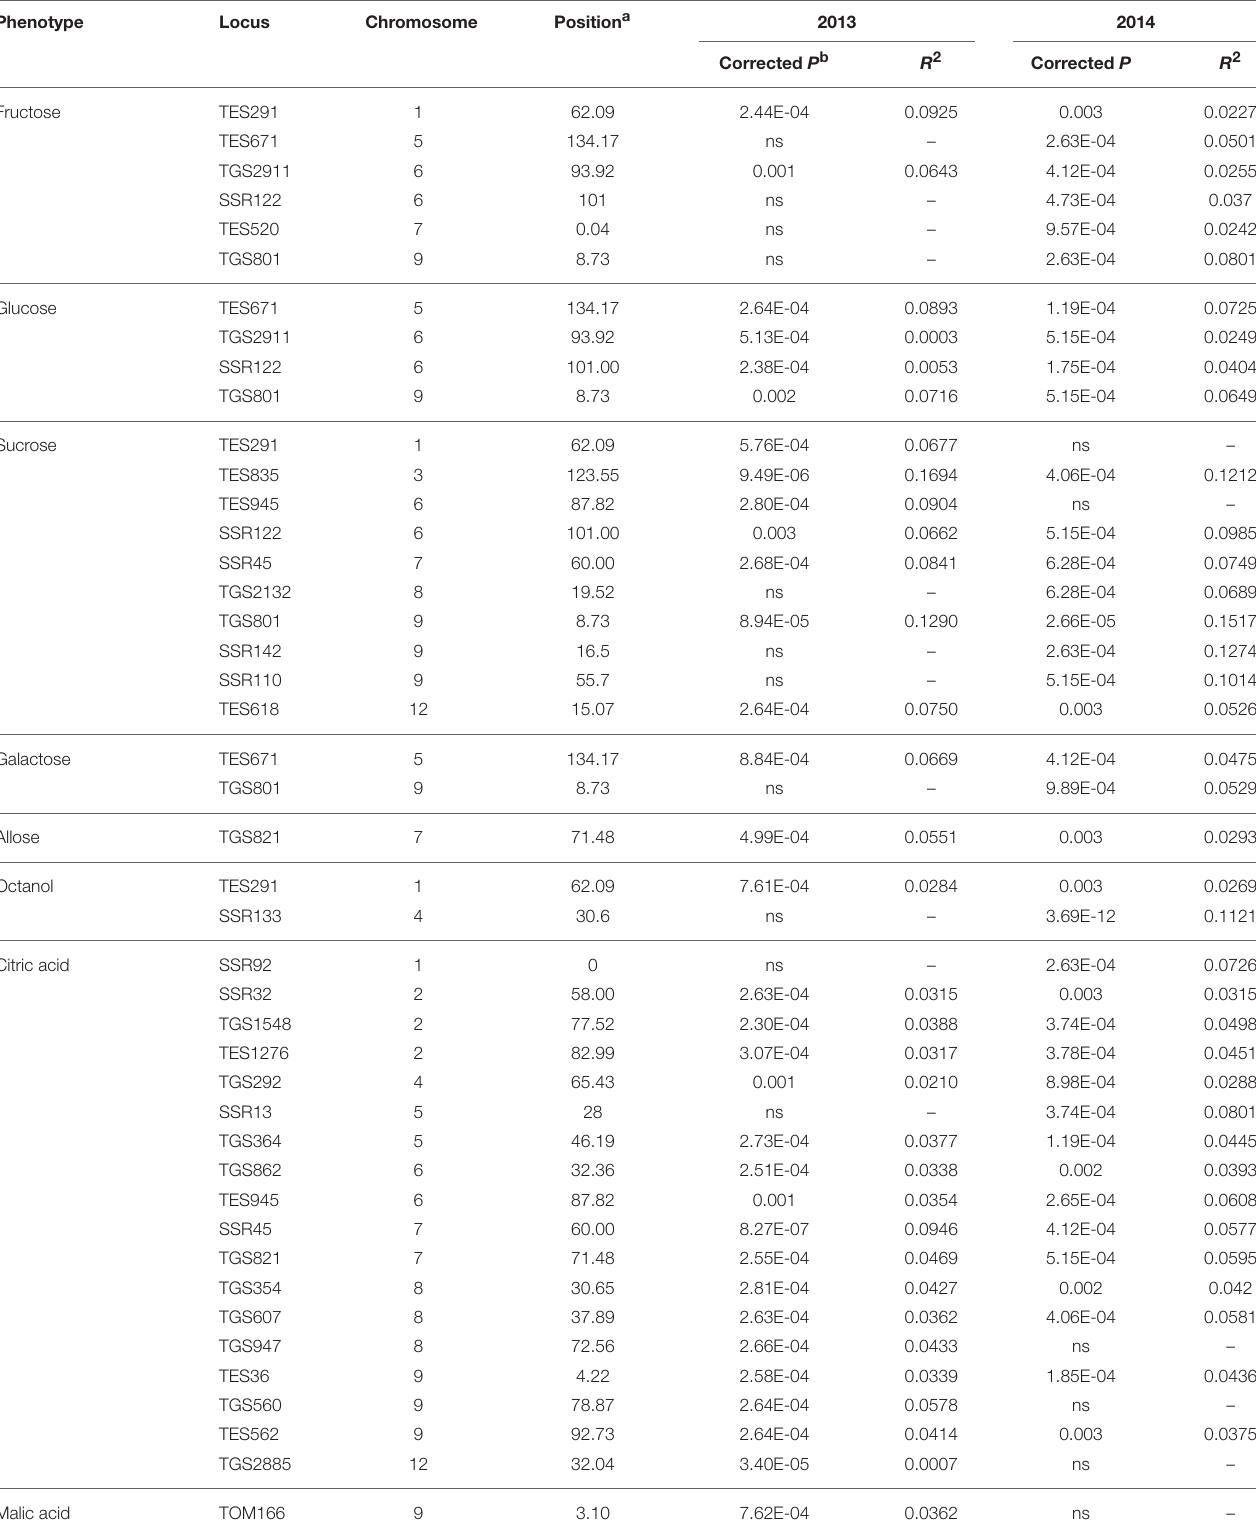
TABLE 2 | Association mapping for 17 sugars, sugar alcohols and organic acids in tomato fruit estimated with K + Q (MLM) model on 174 tomato accessions (only those where P < 0.001 are listed).